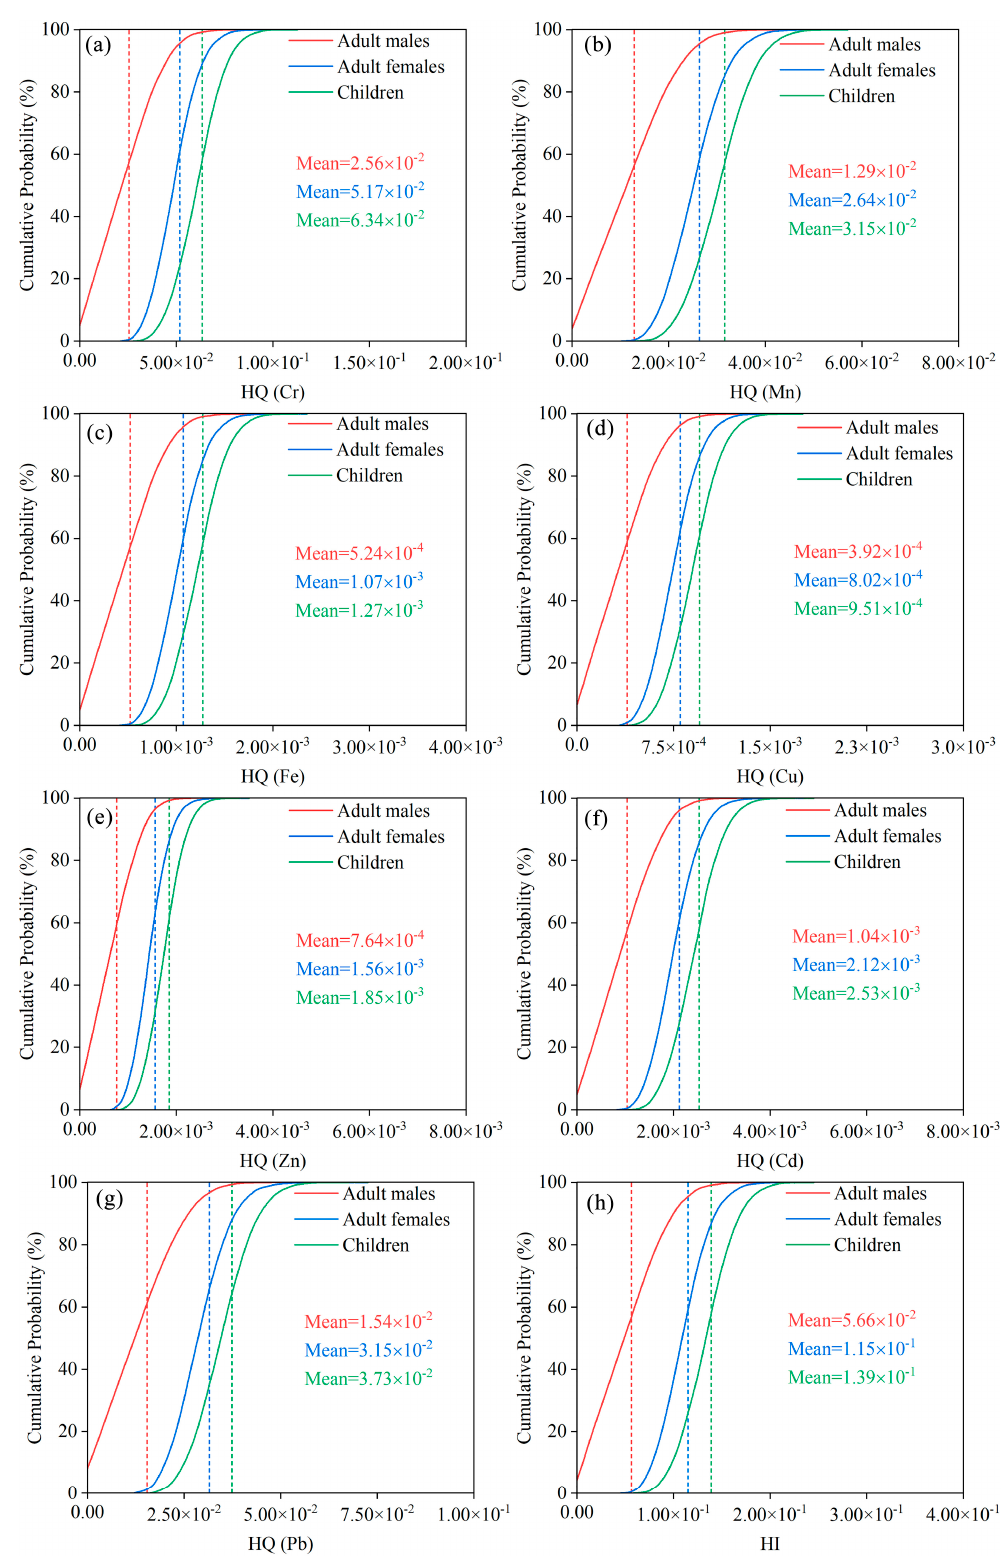
Figure 4. Probability distribution of hazard quotient (HQ) for ( a ) Cr, ( b ) Mn, ( c ) Fe, ( d ) Cu, ( e ) Zn, ( f ) Cd, ( g ) Pb, and ( h ) hazard index (HI) with the percentage of HQ and HI values surpassing 1, the guideline value (The blue, red, or green dashed vertical lines represent the mean values).